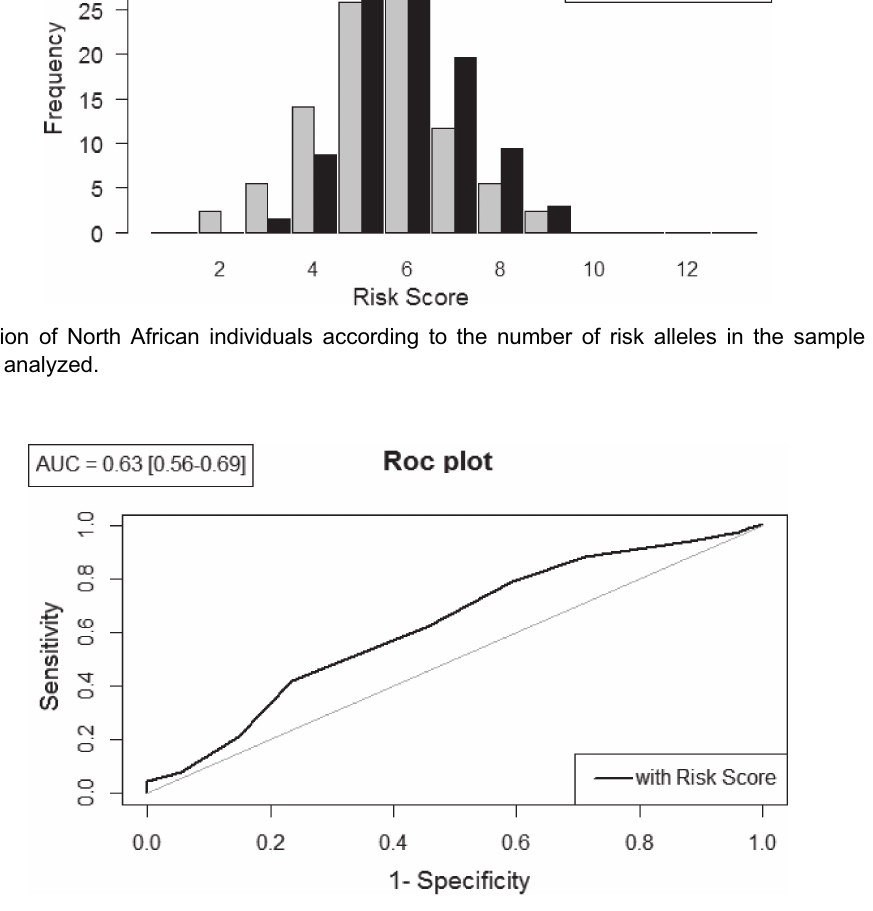
Figure 2. Receiver operating characteristic (ROC) curves in North Africa. AUC, Area Under the ROC Curve with 95% con fi dence interval.